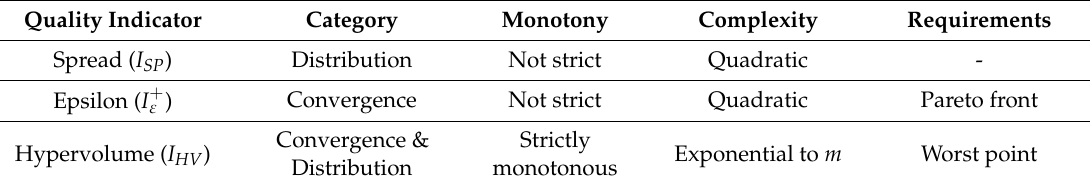
Table 1. Quality indicators considered for the case